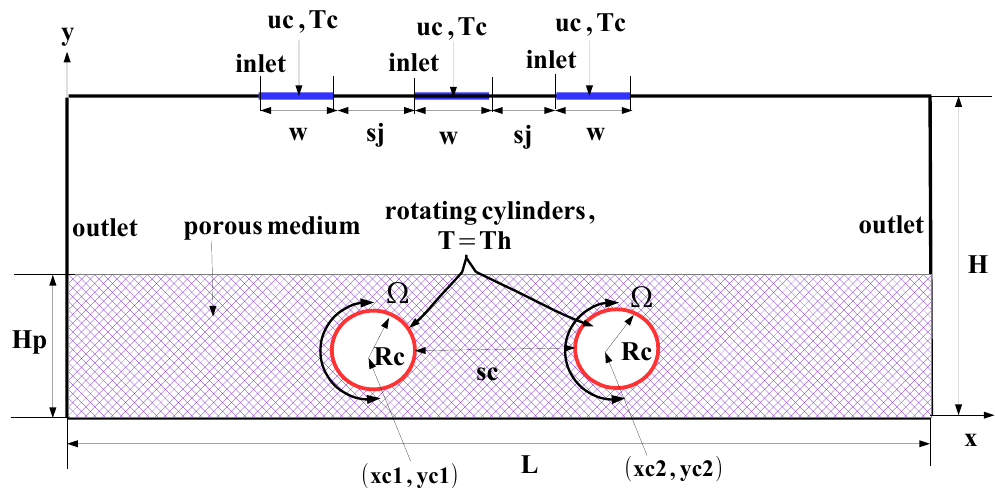
Figure 1. Schematic sketch of computational model.